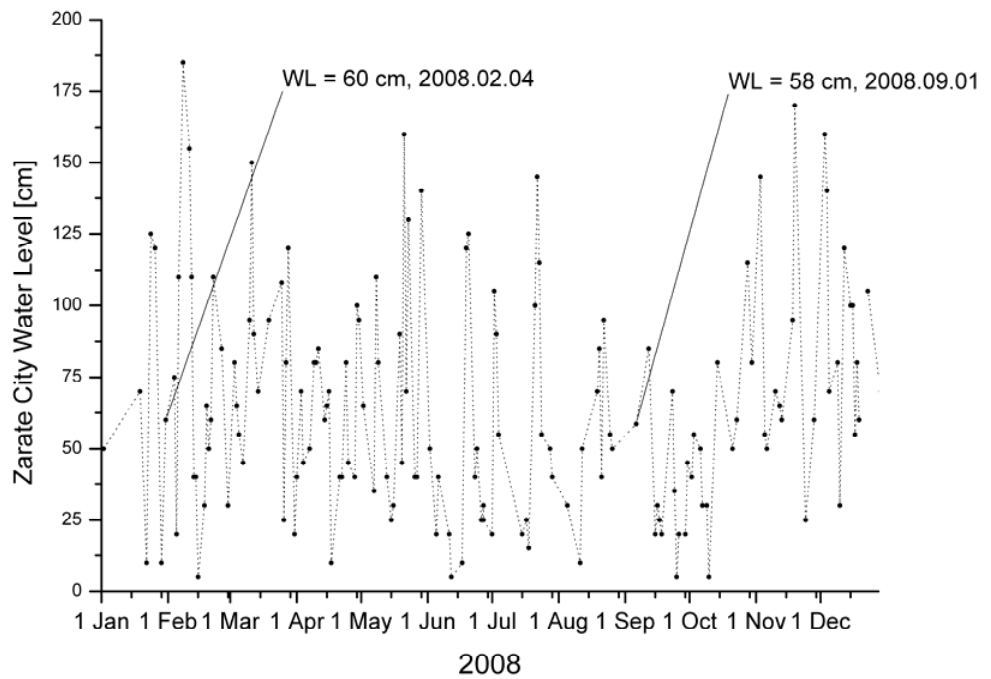
Figure 5. Water level at Zárate city, used to infer water level inside field sites (see [6]). The dates corresponding to ASAR acquisitions are